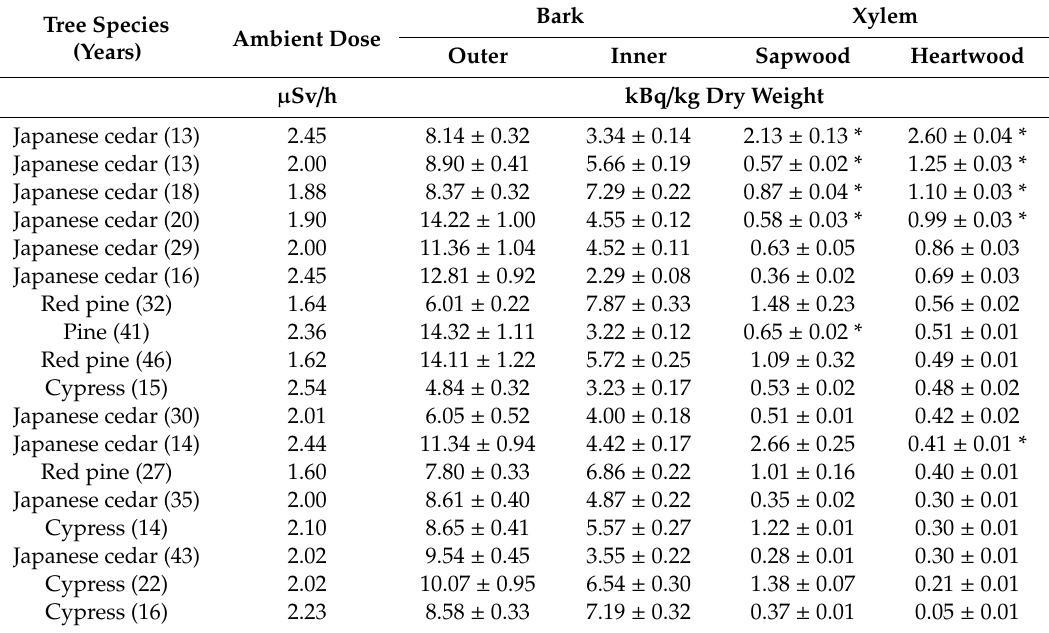
Table 4. Radiocesium ( 134 Cs and 137 Cs) specific activities in trees in the forest (Figure 1: area number 2) on December